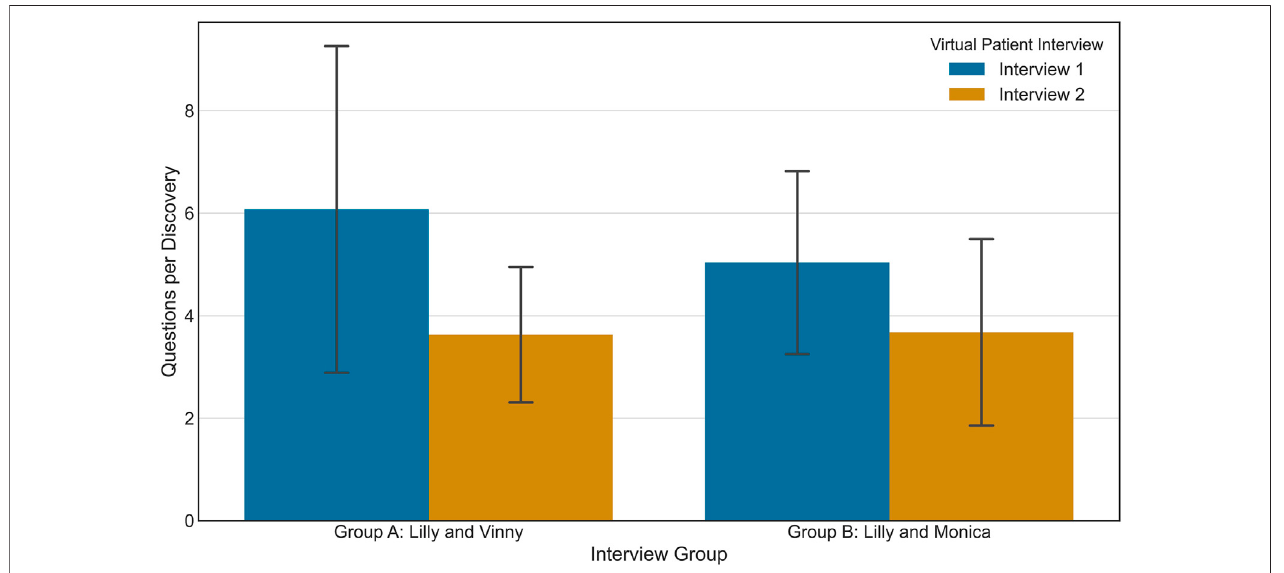
FIGURE 4 | The means and standard deviations of questions per discovery for students in the Message Production Trends study.